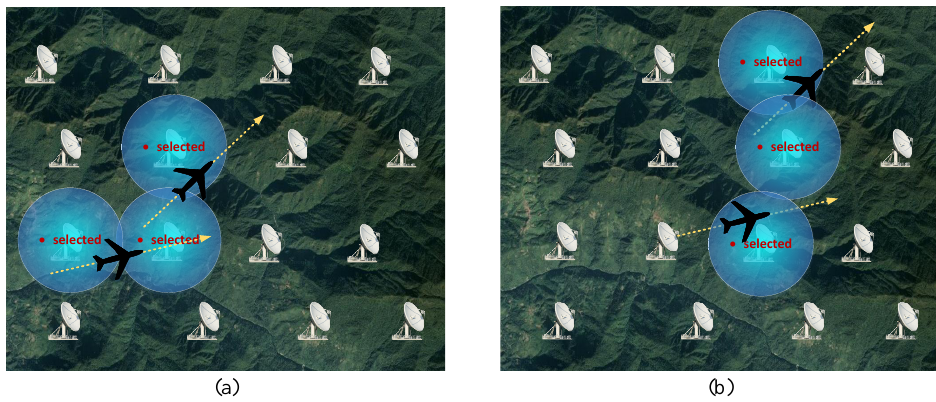
Figure 1. Illustration of dynamic selection of a fixed number of sensors for MTT: ( a ) At time k ; ( b ) At time k + 1. It is assumed that three sensors are selected at each time step, and the blue circles show the coverage areas of the selected